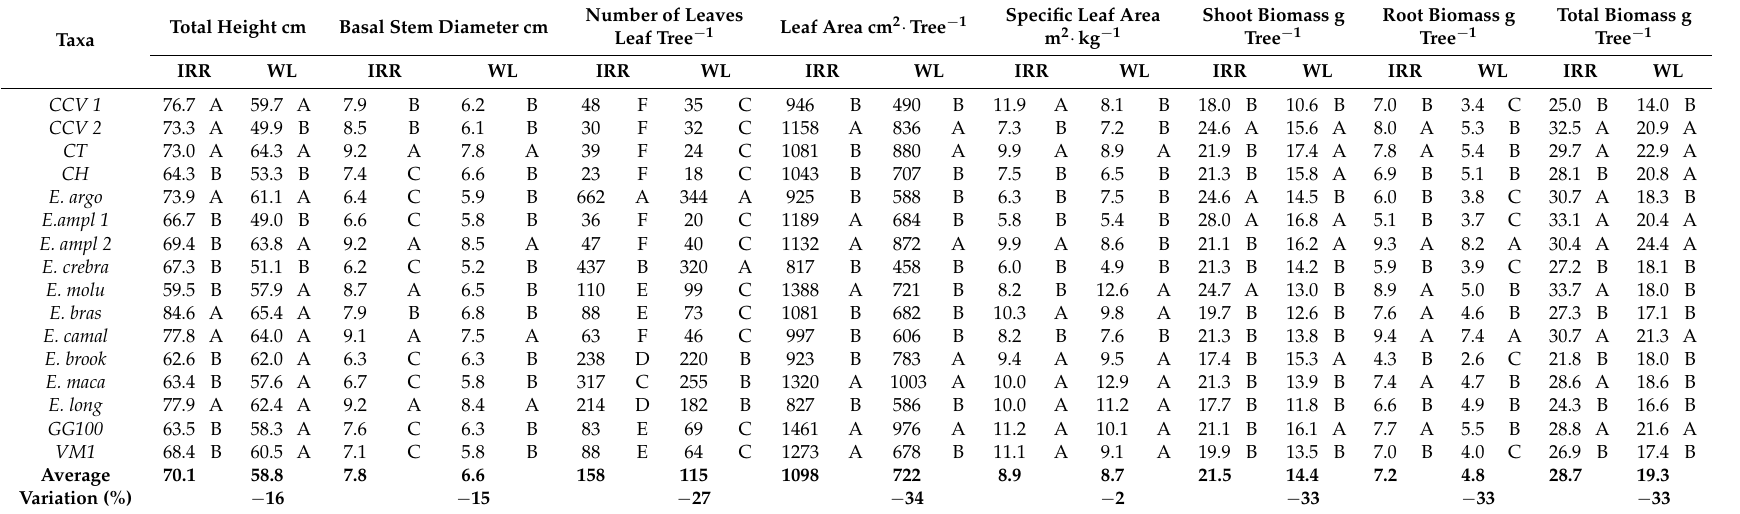
Table 3. Growth and biomass production of the 16 studied taxa at the end of the 70 days of the experiment for soil water limited and irrigated plants. Numbers followed by different letters within each column are statistically different. IRR: irrigated; WL: soil water